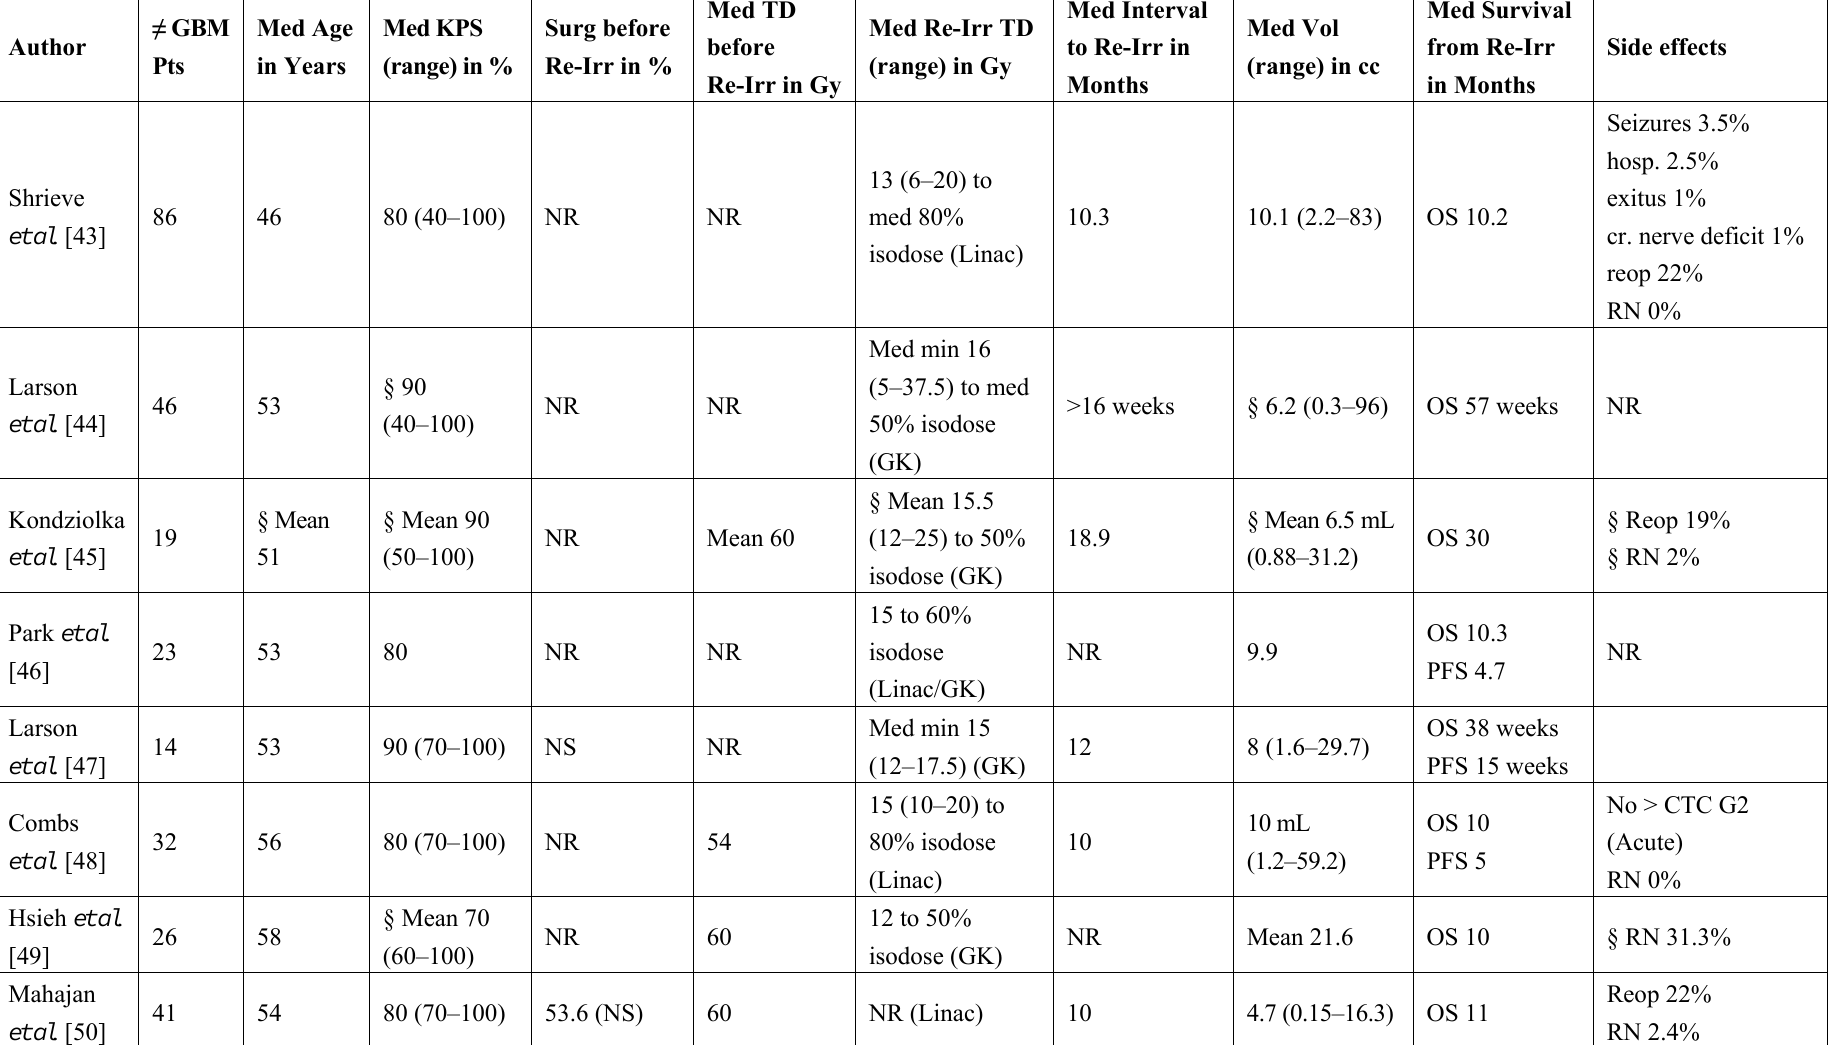
Table 2. Re-irradiation series employing stereotactic